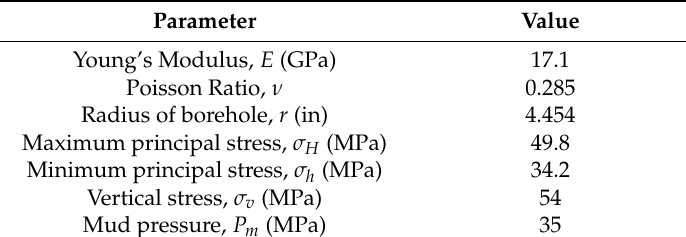
Table 4. In-situ stress, rock mechanical properties, and hole size.